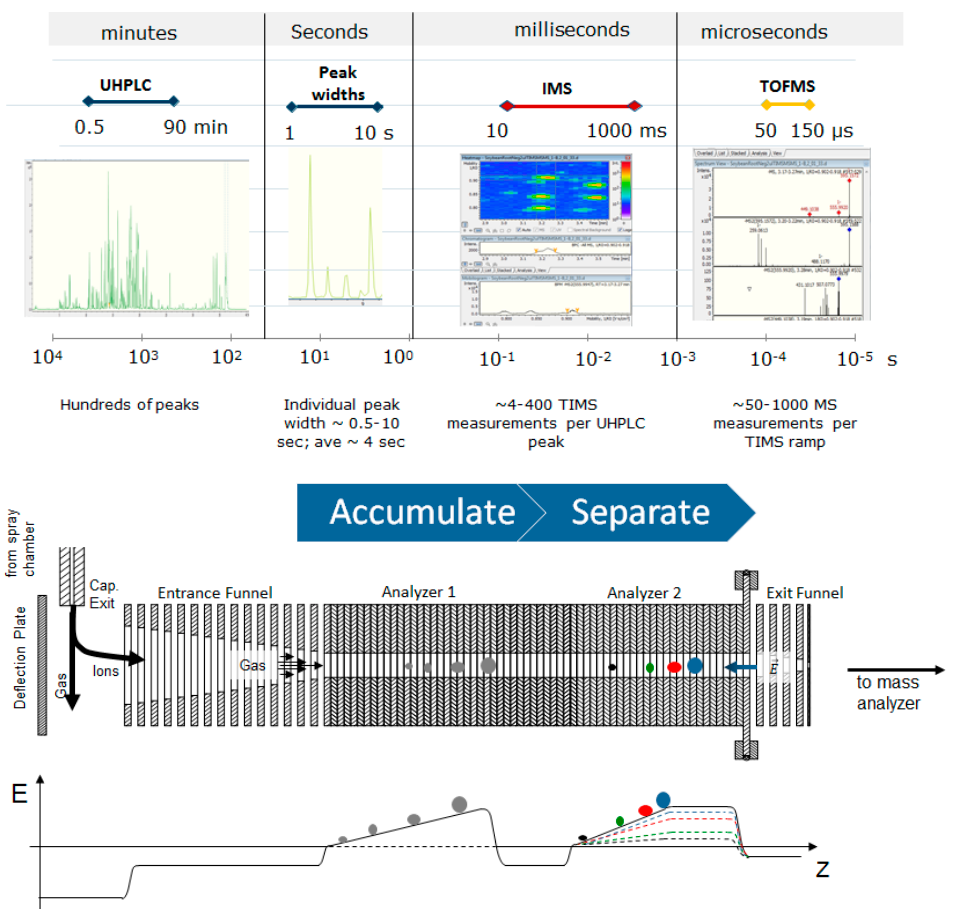
Figure 1. Trapped ion mobility spectrometry (TIMS) is temporally well aligned with UHPLC as a second dimensional separation technology. TIMS also offers higher resolution and a high duty cycle. Ions from the source are pushed through the ion tunnel by a drift gas and opposed by an electric field gradient, in effect trapping them where those forces are equal on the ion. The two stages of the TIMS allow for accumulation of ions in analyzer 1 while separation and mobility measurements take place in analyzer 2. This results in a near 100% duty cycle. As the electric field gradient is lowered, the ions are released from the second analyzer towards the time-of-flight (TOF)